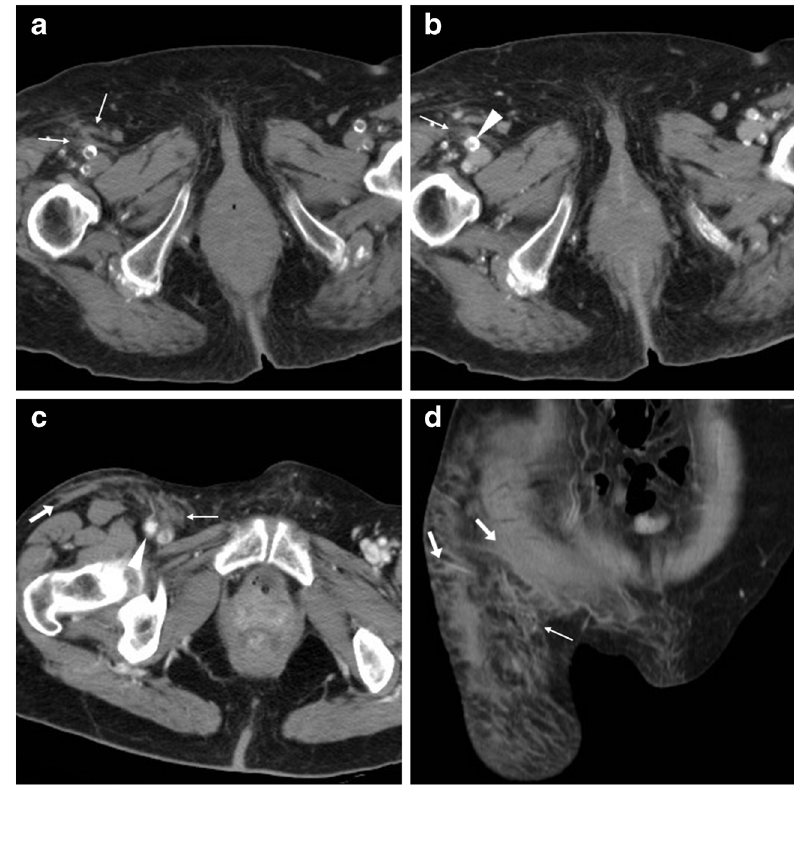
Fig. 2 Delayed groin bleeding in a 70-year-old male patient after transarterial mitral and aortic valve replacement. Early CT (A, B) showed circumscribed effu- sion (*) abutting the CFA at the level of percutaneous access, which was interpreted as a minor bleed and treated conservatively. However, during hospitalisation for infected sternal dehiscence, repeated CT angiography (C, D) showed development of a 4.5-cm groin haematoma (*) containing a thin contrast medium (CM) ex- travasation focus (arrowheads), causing compression on the CFA (MIP image D) which required